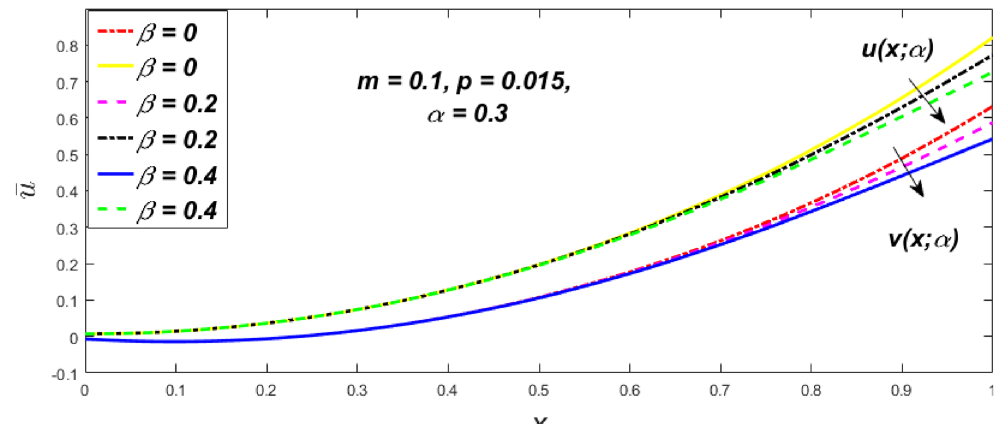
Figure 29. Fuzzy velocity profiles for the impact of β .